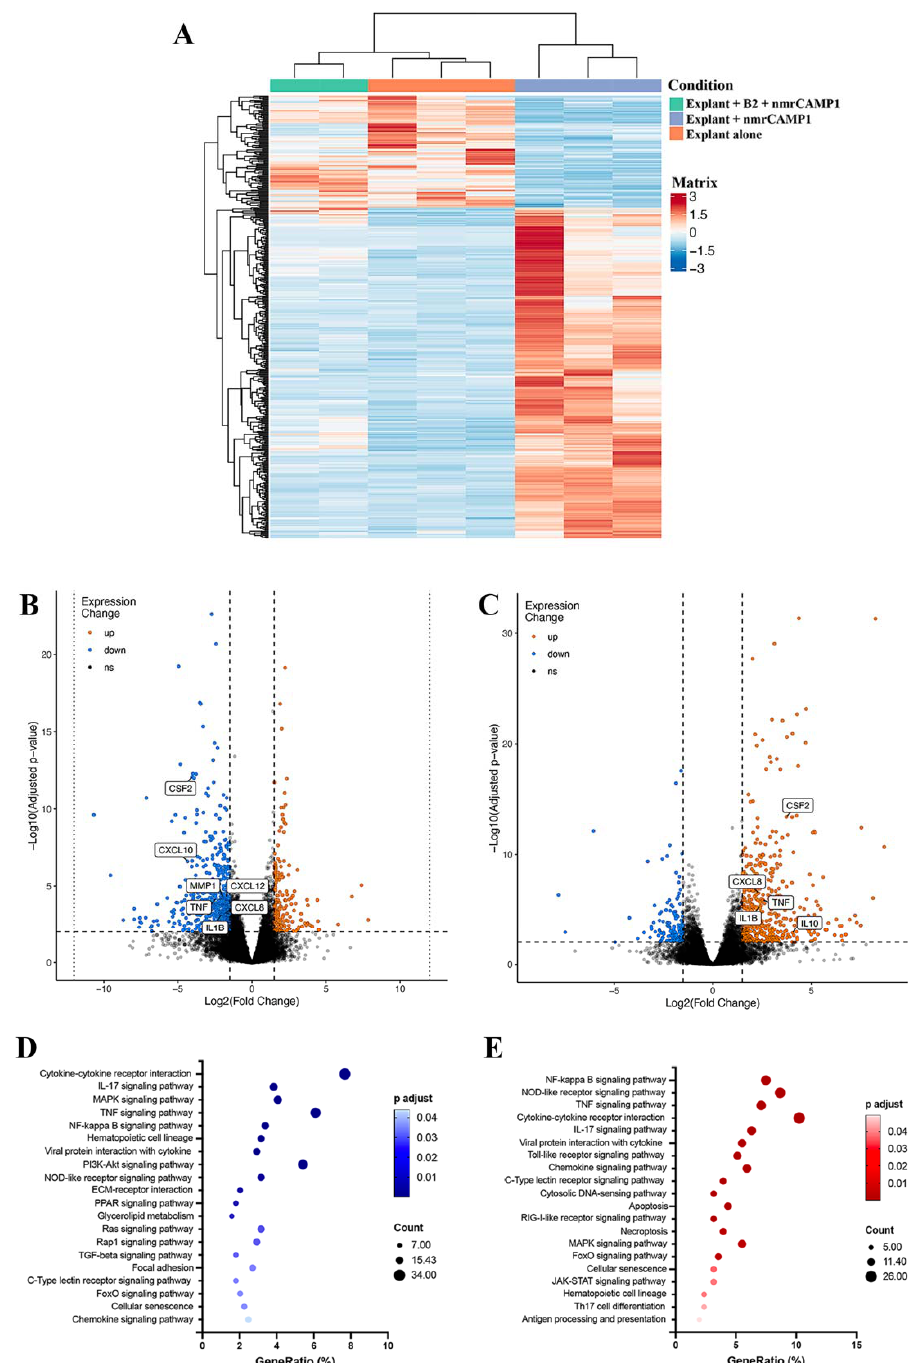
Figure 9. RNA sequencing analysis for nmrCAMP1-induced inflammation and after B2 CAMP1-related peptide treatment. Screening and enrichment analysis on differentially expressed mRNAs in human skin explants treated with B2 CAMP1-related peptide and stimulated with nmrCAMP1 relative to human skin explants stimulated with nmrCAMP1. ( A ) Cluster analysis for mRNAs between the unstimulated and untreated group ( n = 3), the stimulated group ( n = 3) and the treated and stimulated group ( n = 2). ( B , C ) Volcano plots on total mRNA between the treated and control groups (thresholds p < 0.05 and log2(fold-change) > 1.5 in either direction). ( D , E ) KEGG pathway enrichment analysis performed with the David Bioinformatics Resource on the downregulated and upregulated gene groups, respectively (thresholds p < 0.05, log2(fold-change) > 1.5 in either direction, and basal state mean > 100).